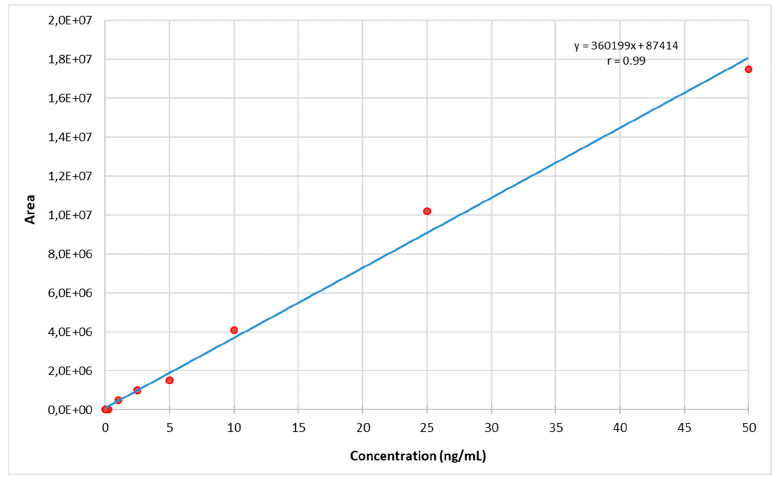
Figure 4. Calibration curve for THC.